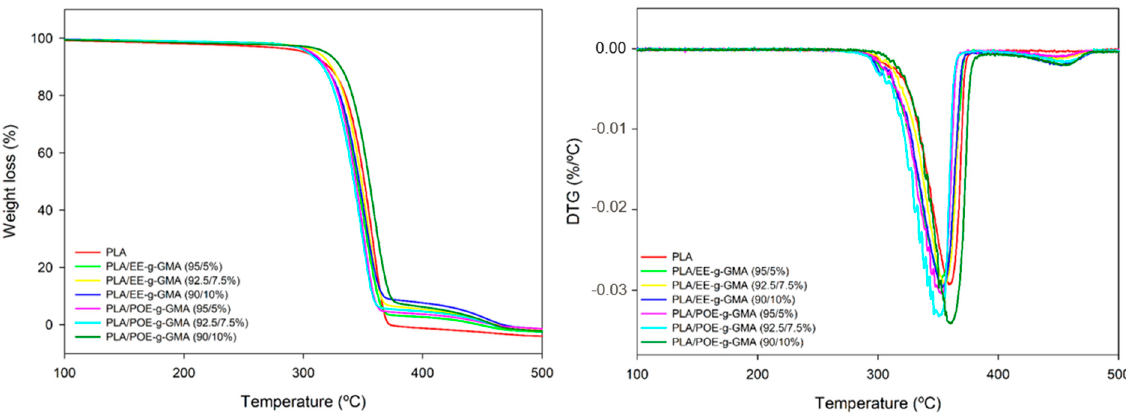
Figure 9. TG and DTG curves of pure PLA and the blends containing 5; 7.5 and 10% EE-g-GMA and POE-g-GMA. Table 3. Degradation data obtained from TG of the